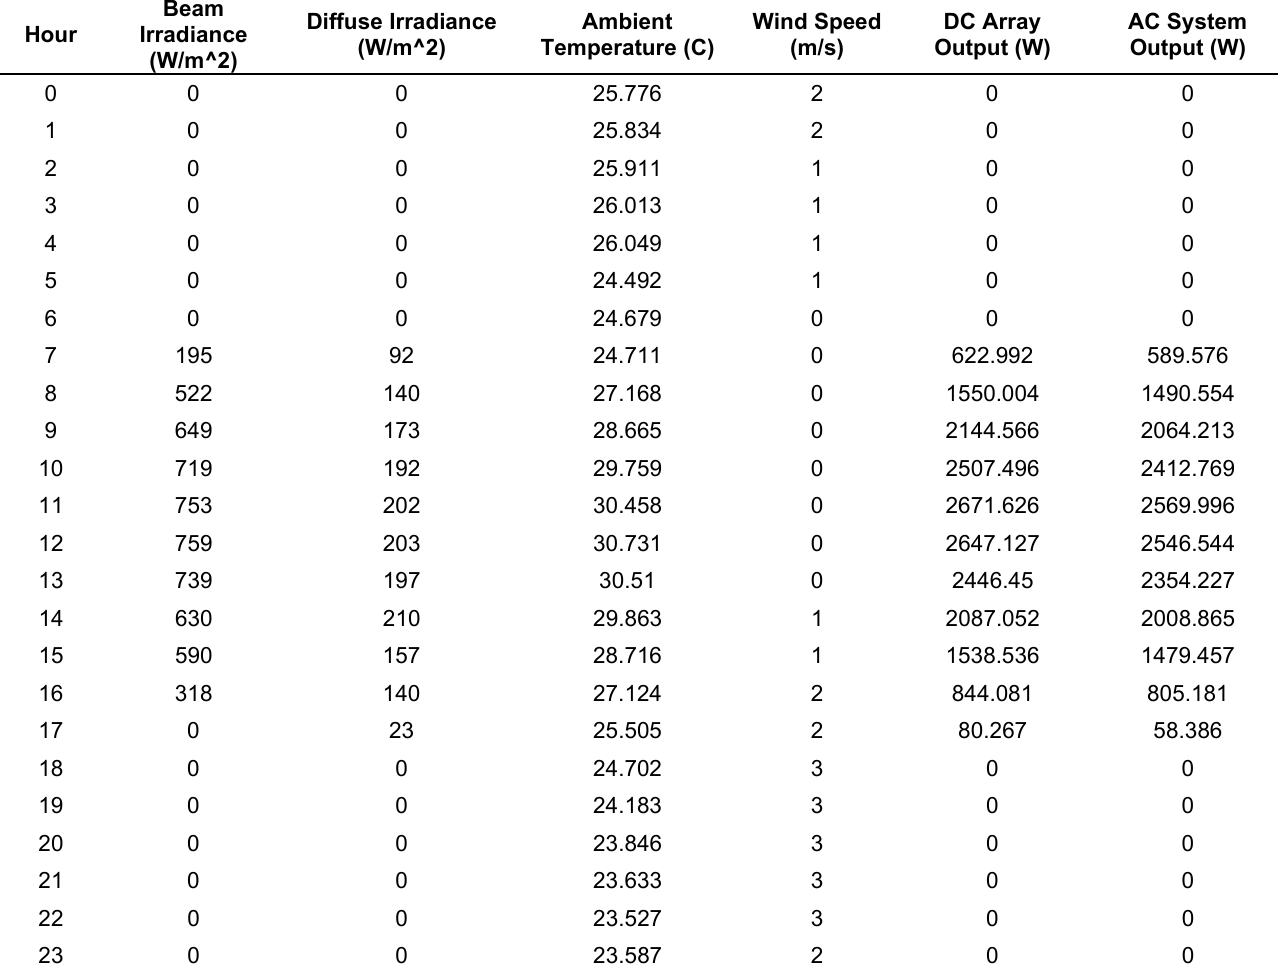
Table 2. Sample of Meteorological data from